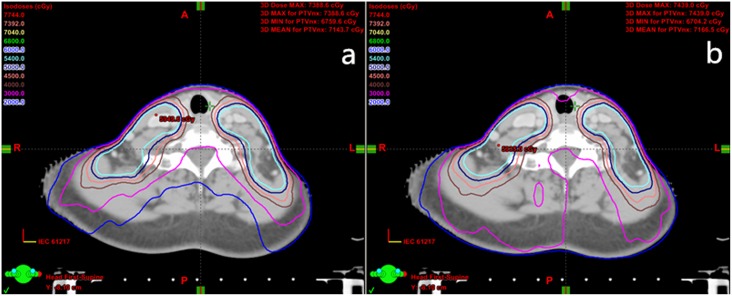
Isodose distributions of the large-field volumetric arc therapy (LF-VMAT) and fixed-jaw VMAT (FJ-VMAT) plans.(a) The FJ-VMAT plans. (b) The LF-VMAT plans. Eleven dose lines of 20–77 Gy from the outside to the inside of each CT image.